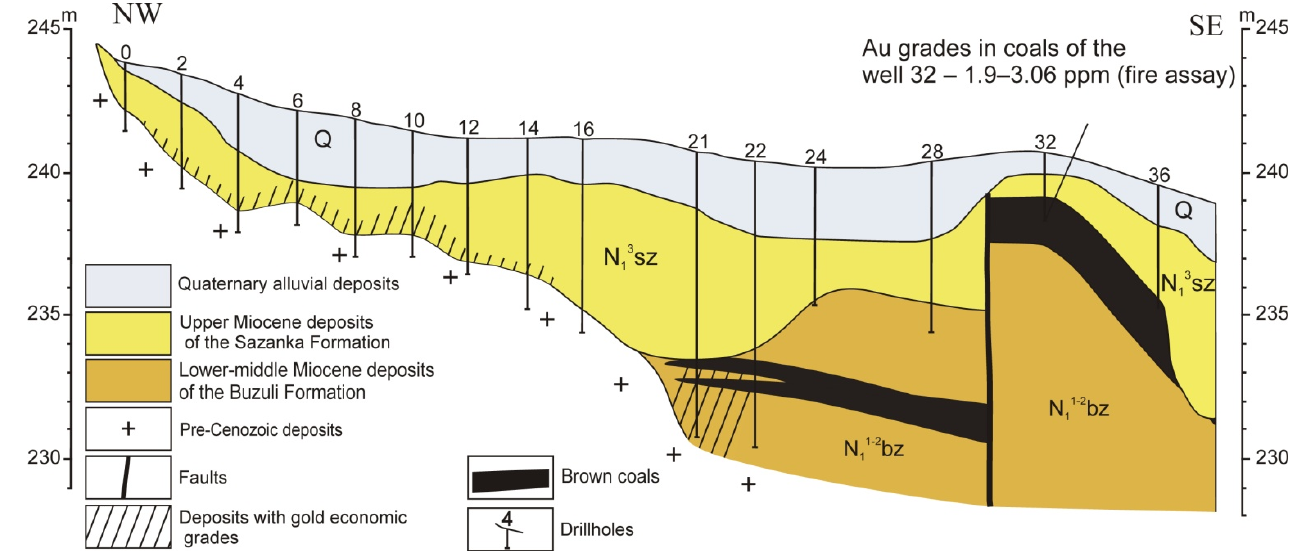
Figure 3. Geological section of gold placer in Gryaznushka Creek.